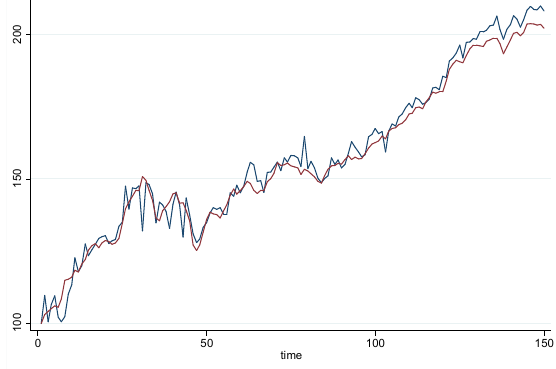
Figure 3. Geography segments. Note: The apartment price index. The Stockholm housing market and segments of the market (the x -axis is the measuring price index and the y -axis is the measuring time). The red line is equal inner city and the blue is equal outer city.